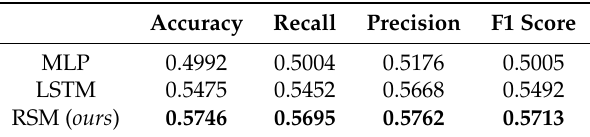
Table 5. Universal patterns (LTCCNY). Model evaluation scores use the same metric as in Table 1. We evaluated the same baselines and our model on a different dataset from the dataset on which they were trained. Lite Coin Chinese yuan (LTCCNY) in the OkCoin market was used as the evaluation dataset. We used the parameters optimized on BTCUSD.